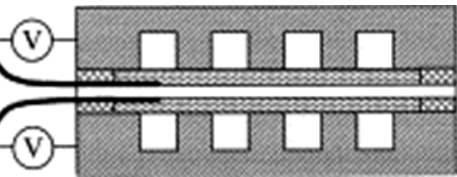
Figure 5. Scheme of method for in situ contact resistance measurement according to Makkus. Reprinted from [64] copyright (2000), with permission from Elsevier.